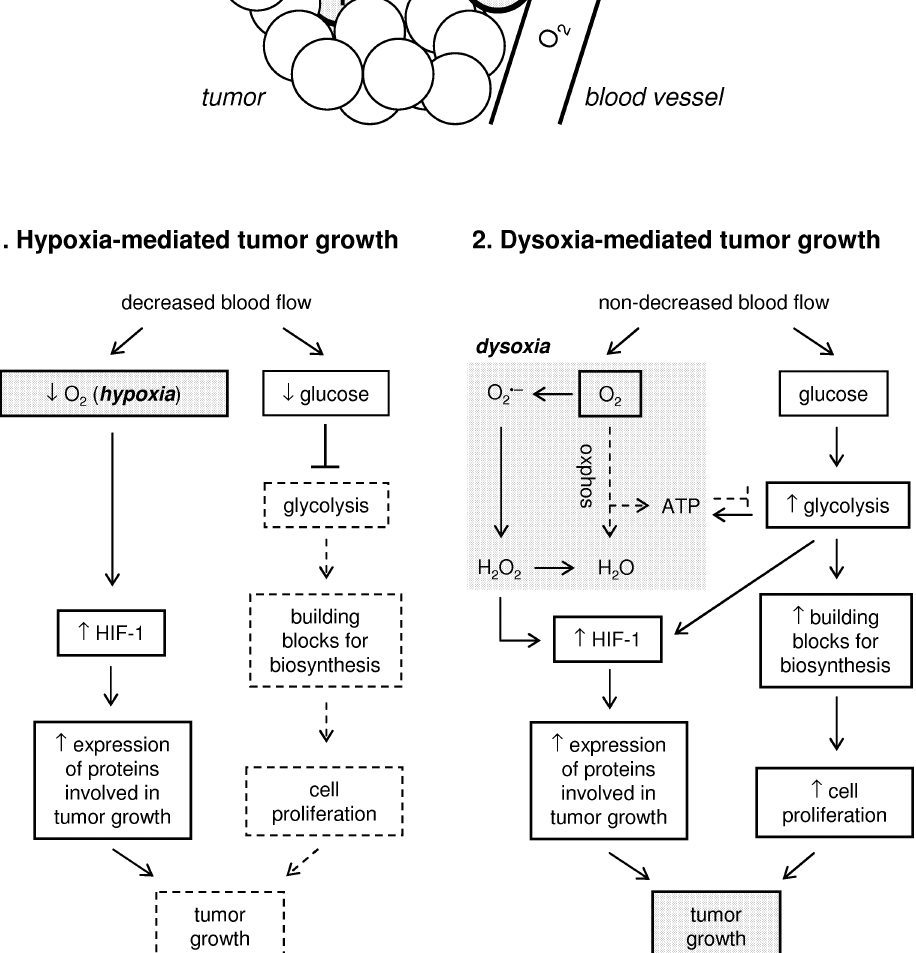
Fig. 1. Tumor growth may not be controlled by oxygen limitation (hypoxia) but by an alteration in oxygen metabolism (dysoxia) . This figure represents that a cell with a decreased blood flow (cell number 1) has a reduced supply of both O 2 and glucose. The reduced O 2 supply would cause the activation of HIF-1, a transcription factor that favors tumor growth. However, the reduced glucose levels would restrict the proliferation of this cell. As a result, cell number 1 would not contribute to tumor growth substantially. A cell with a non-reduced blood flow and an alteration in oxygen metabolism (cell number 2) would activate HIF-1 and would not have a restricted proliferative capacity caused by glucose deprivation. Cell number 2, therefore, would contribute to tumor